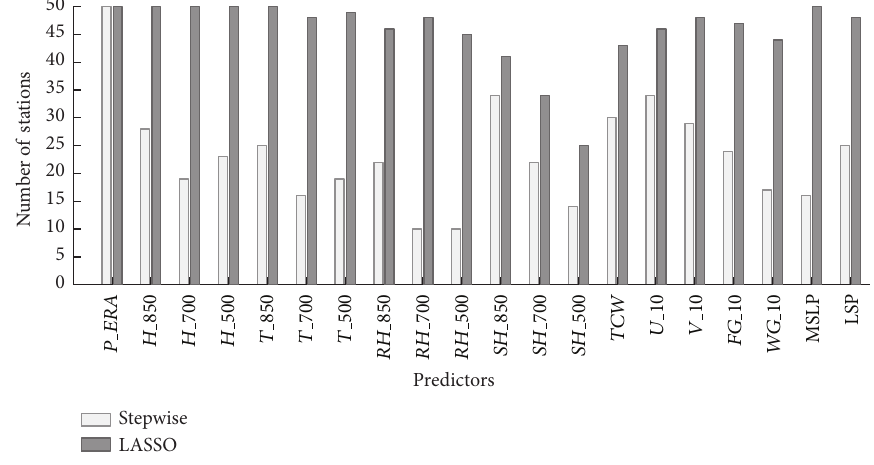
Figure 9: Selected variables in Stepwise and LASSO for precipitation amount prediction on wet